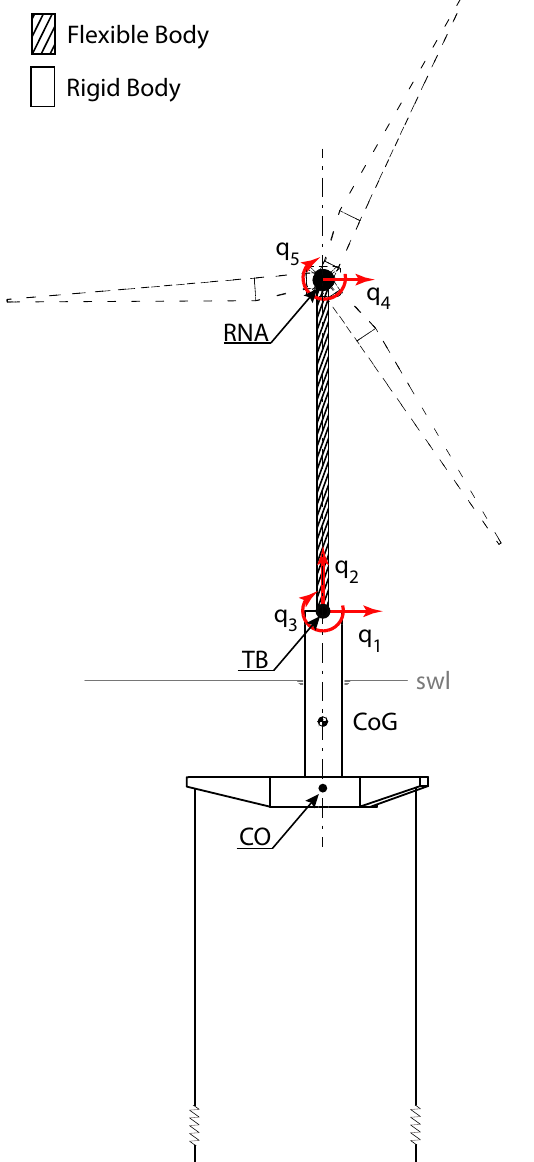
Figure 2. Definition of the system’s DOFs and key points. RNA, rotor-nacelle assembly; TB, tower bottom; swl, still water